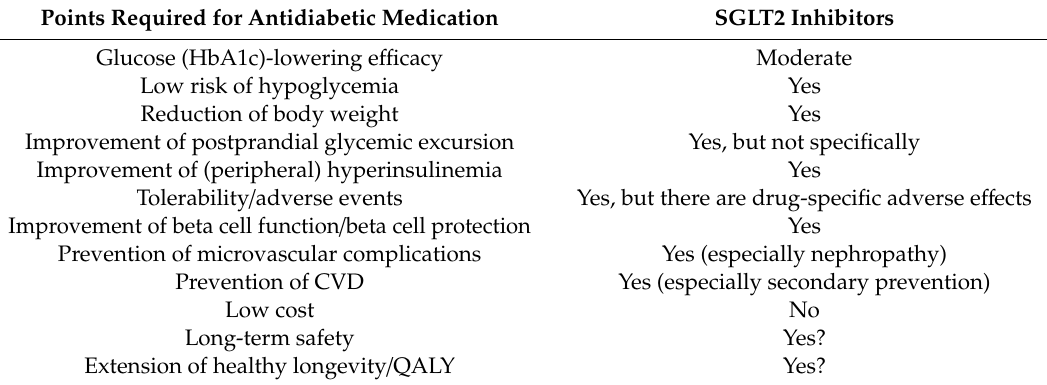
Table 5. Potential of SGLT2 inhibitors in treatment of